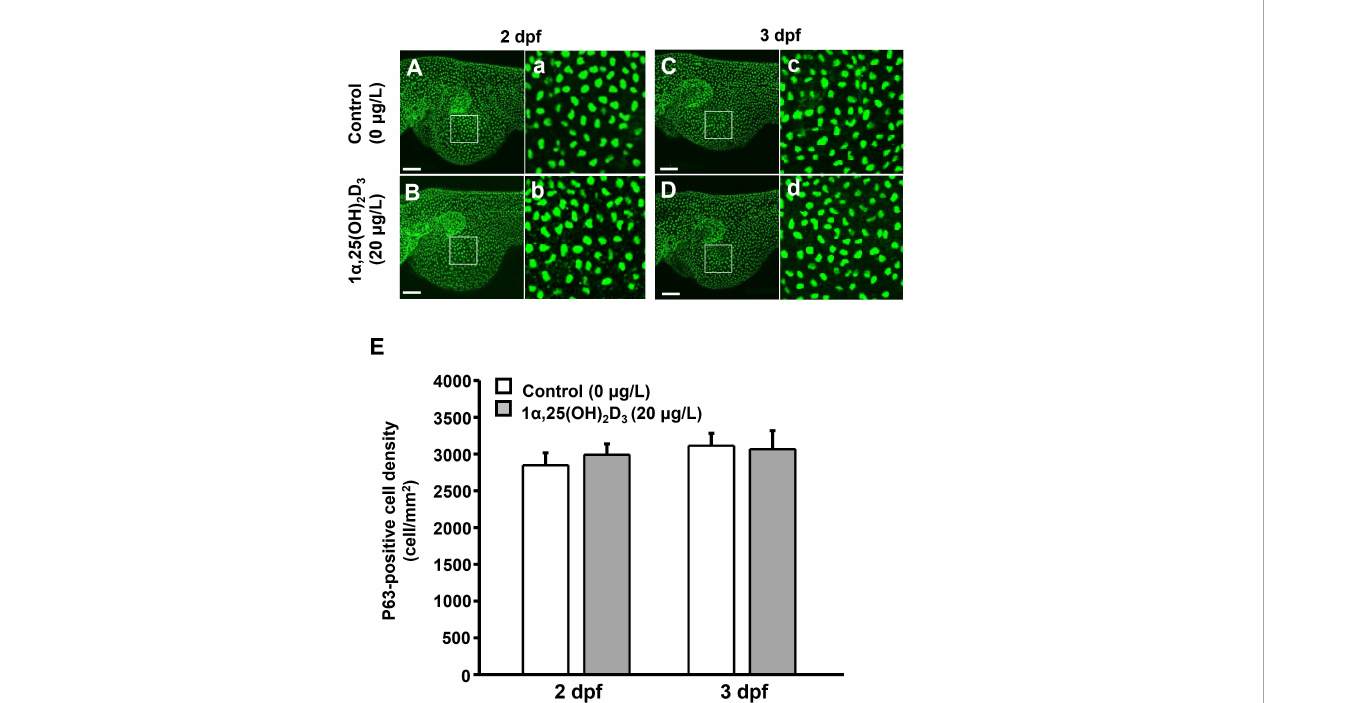
FIGURE 4 Effects of exogenous 1 a ,25(OH) 2 D 3 treatment on the density of P63-positive cell at the embryonic skin of 2 and 3 dpf zebra fi sh larvae. (A – D) The representative images of whole mount immunocytochemistry showing the expression of P63-positive cells (green dots) in the yolk sac of zebra fi sh larvae treated with 0 (control) and 20 m g/L 1 a ,25(OH) 2 D 3. (a-d) The enlarged images of white squares from (A – D) . (E) The quantitative data for the cell density. Values are mean ± SEM ( n = 9). Scale bar: 100 m